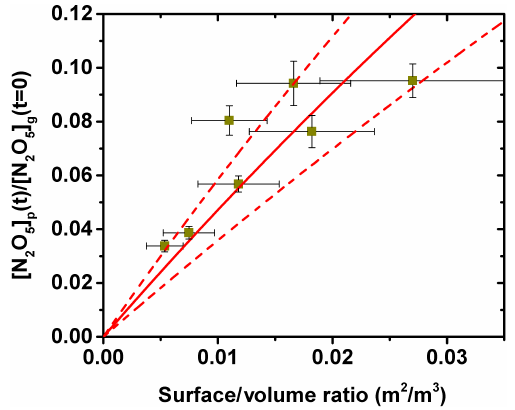
Figure 2. Normalized particle-phase N 2 O 5 concentration vs. aerosol surface area to gas volume ratio for the experiment from Fig. 1. The data points represent experimental data; vertical error bars represent a 95% confidence interval, horizontal error bars rep- resent the S/V measurement error (30%), the full red line is the fitted series determined by least-squares fitting of Eq. (2) to experi- mental data, the dashed red lines are 95% confidence intervals.